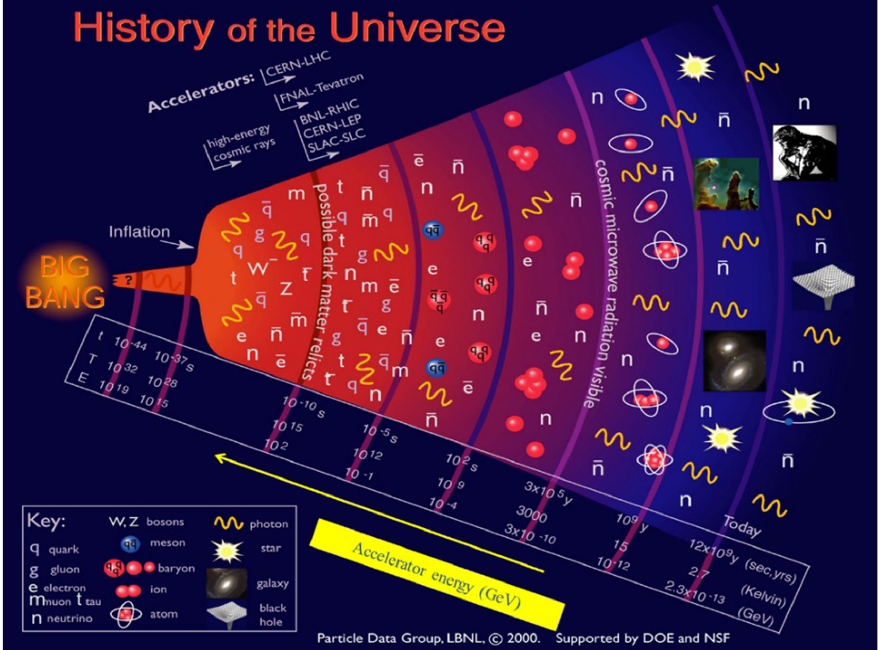
FIG. 1. History of the